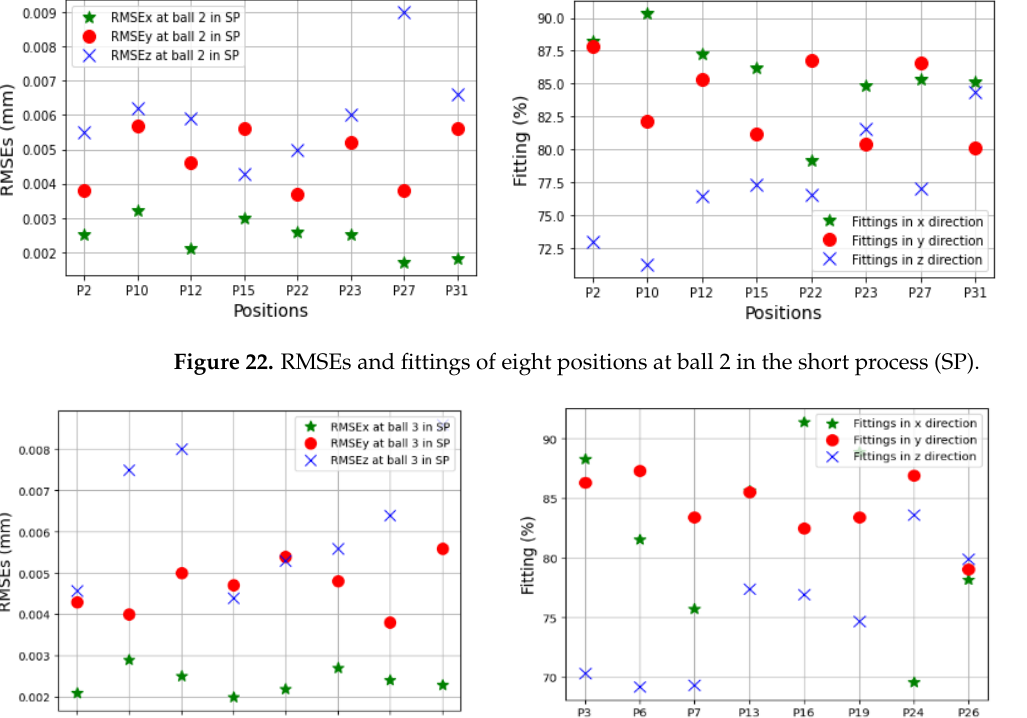
Figure 21. RMSEs and fittings of eight positions at ball 1 in the short process (SP).